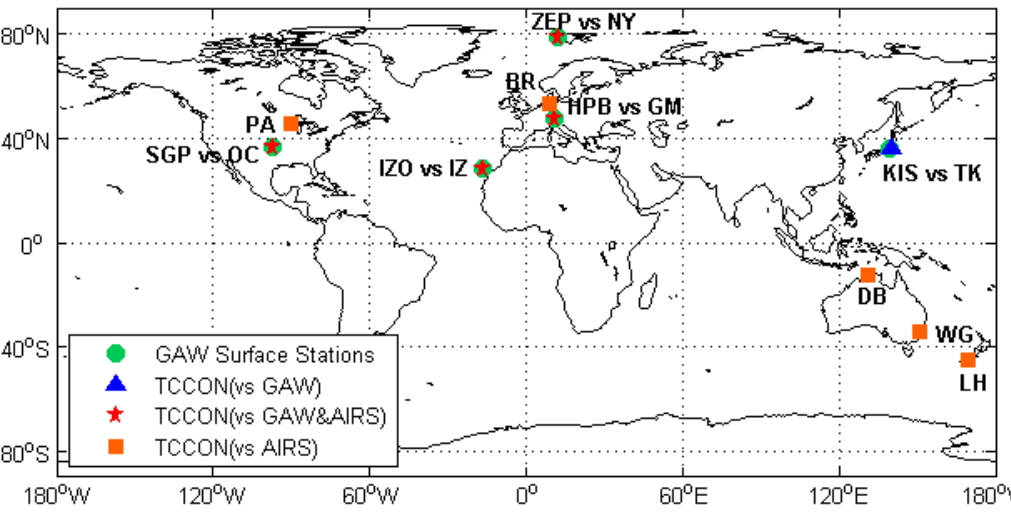
Figure 4. Locations of GAW surface stations (green dots ● ) and TCCON sites (blue triangle ▲ , red stars ★ and orange square ■ ).